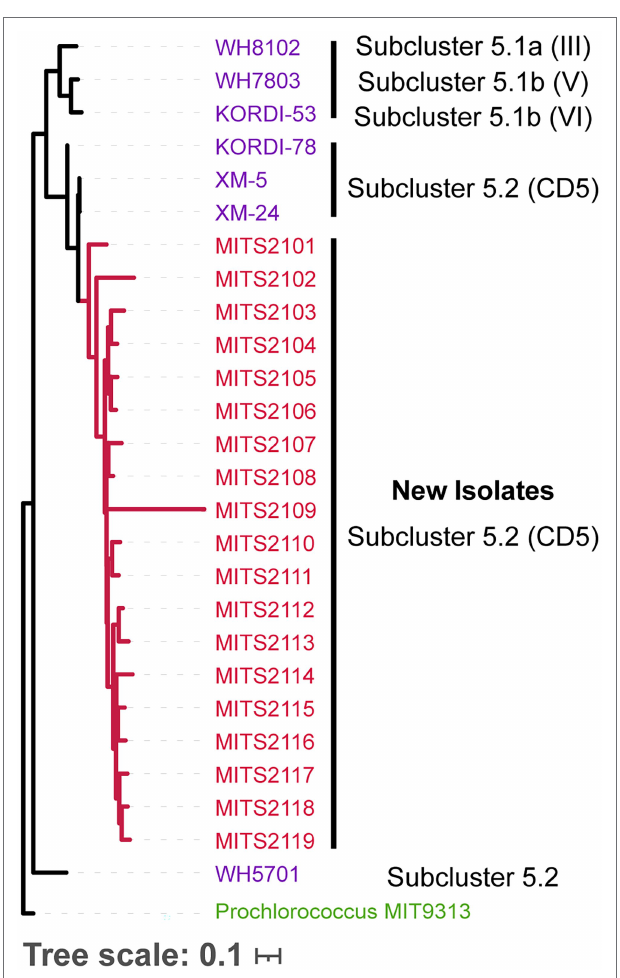
FIGURE 3 | Phylogenetic tree of the 16S-18S internal transcribed spacer (ITS) sequence (for molecular methods, see Rocap et al., 2002; MUSCLE Edgar, 2004 was used to generate the ITS alignment, and FastTree Price et al., 2010 to generate the tree, sequences are available at https://doi. org/10.6084/m9.figshare.17076446) for Synechococcus isolates obtained from natural seawater using the filter plating technique described here (red), with previously isolated Synechococcus strains (purple), annotated with their lineages. Strains are colored by subcluster. Prochlorococcus str. MIT9313 ITS (green) sequence serves as the outgroup to root the